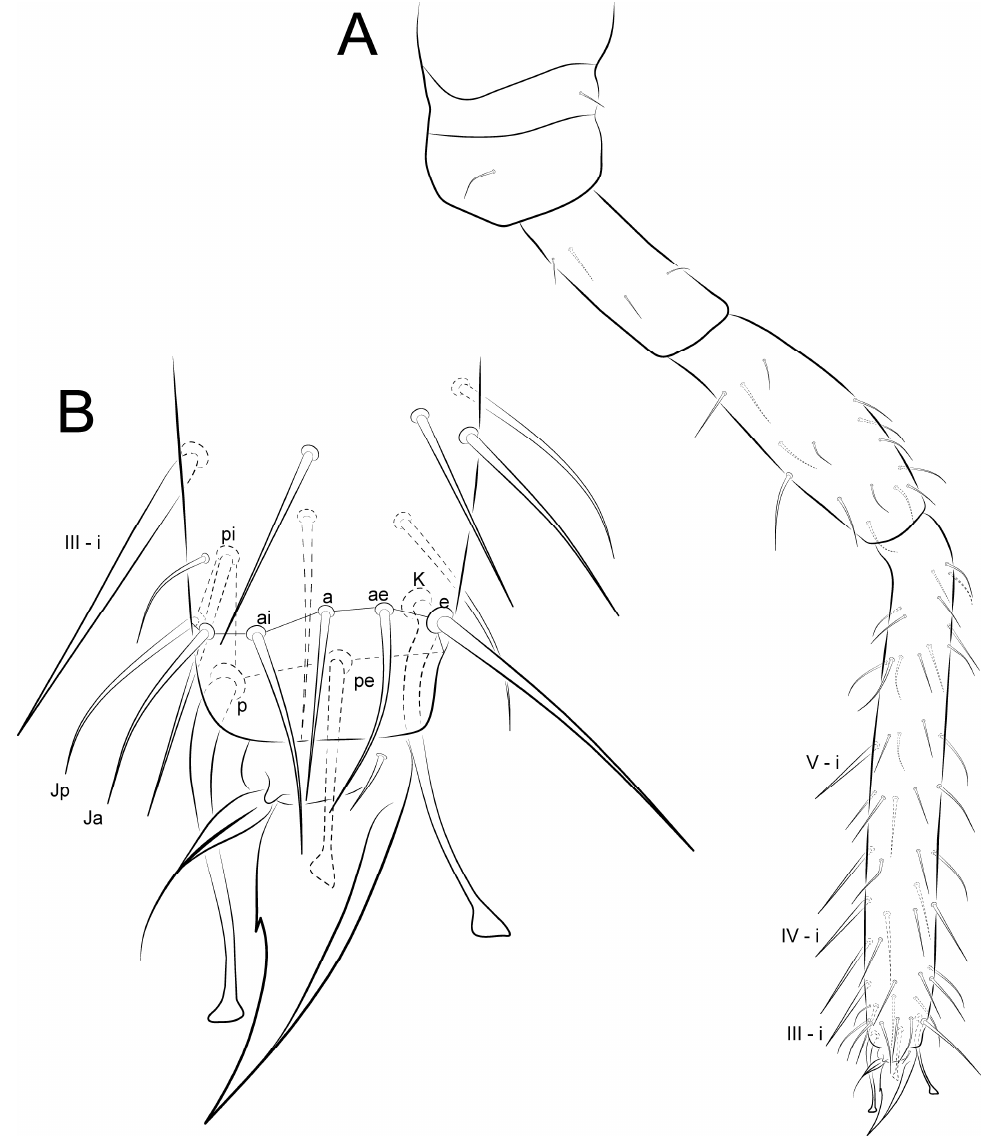
Figure 14. Arlesminthurus caatinguensis sp. nov. male’s leg I (anterior view): ( A ) complete chaetotaxy; ( B ) distal tibiotarsus and empodial complex.